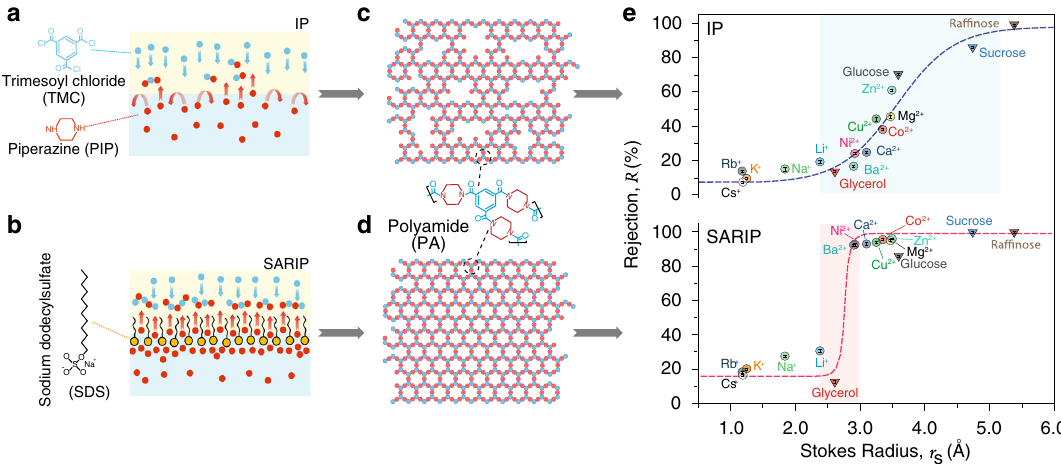
Fig. 1 Conventional IP vs. SARIP. Schematic illustration of ( a ) the conventional IP and ( b ) SARIP. In both cases, PIP molecules in aqueous phase diffuse across the water/hexane interface to react with TMC in the hexane phase. In SARIP, SDS molecules added into the aqueous phase form a self-assembled dynamic network at the interface and regulate the interfacial transport of PIP. ( c , d ) Schematic illustrations of the PA active layer formed via conventional IP (top), which has a heterogeneous pore size distribution, and SARIP (bottom), which has a uniform pore size distribution. ( e ) Rejection of different solutes (circles for cations and inverted triangles for neutral organics) as a function of the Stokes radius for the PA membranes fabricated using conventional IP (top) and SARIP (bottom). Ion rejection vs. hydrated radius is also presented in Supplementary Fig. 1 and Supplementary Table 1, which demonstrates a qualitatively similar comparison between the two PA membranes as shown here. The aqueous SDS concentration in SARIP is 2.1 mM. The rejection of different species was measured from NF experiments with the respective membranes using a cross- fl ow fi ltration cell with an operating pressure of 4 bar and a cross fl ow velocity of 2.9 cm s − 1 . Rejection data of each solute represents the average of three runs and error bar represents the standard deviation of three replicate